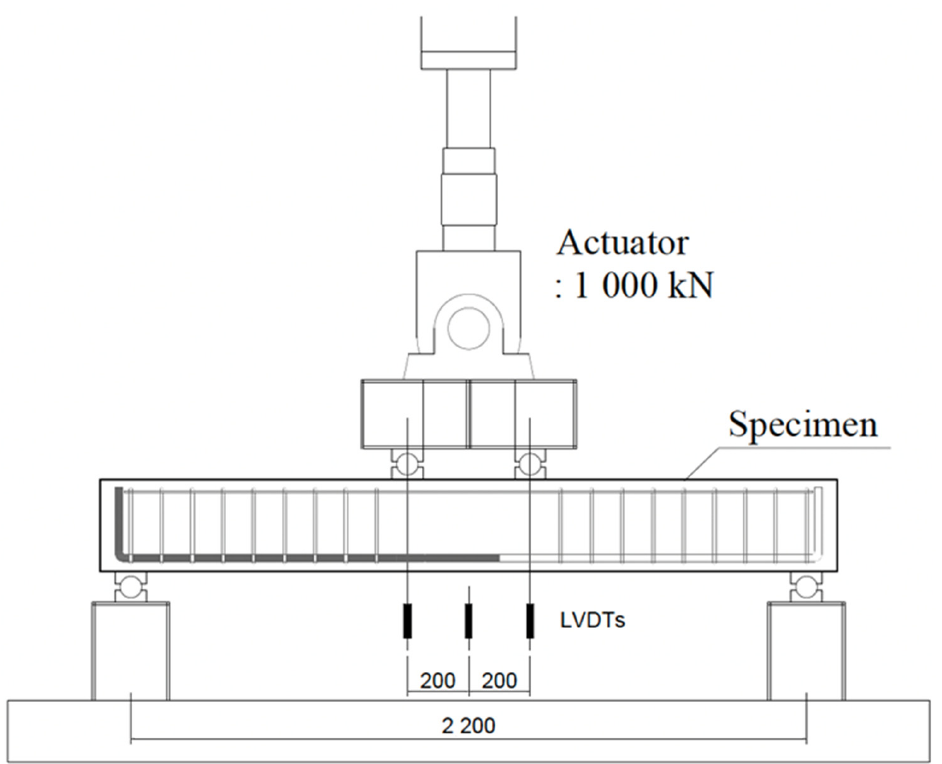
Figure 2. Test Figure 2. Test Setup.